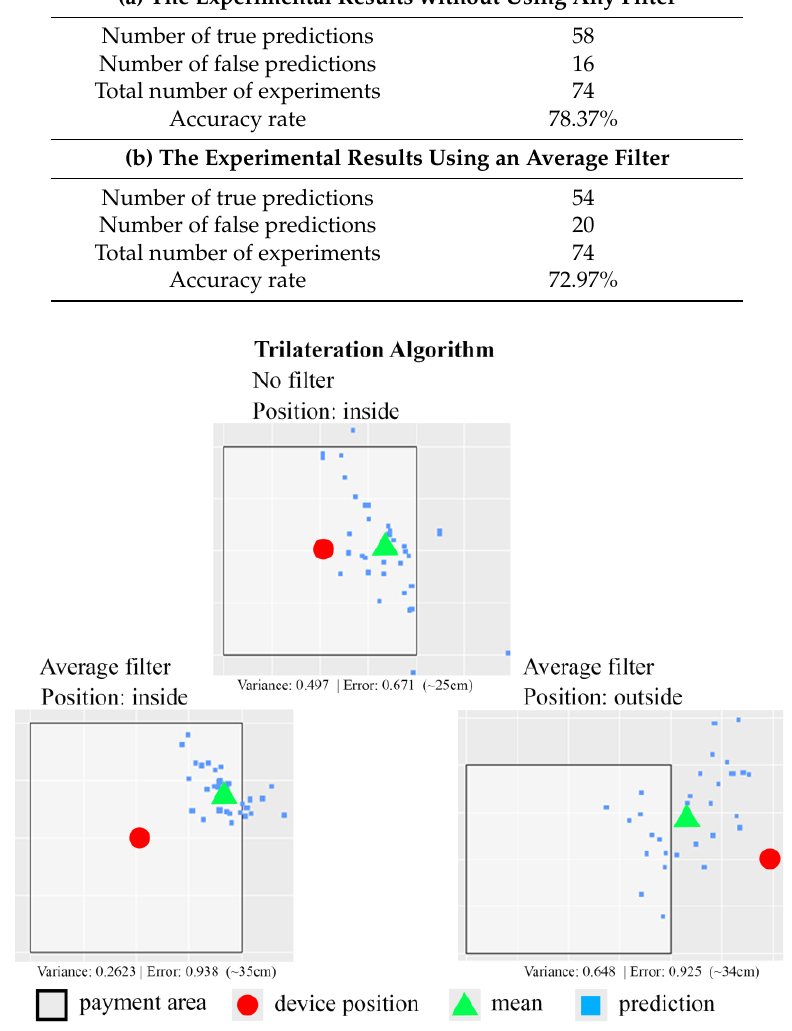
Figure 13. A sample of one experiment result for estimation of customer smartphone position using trilateration algorithm.